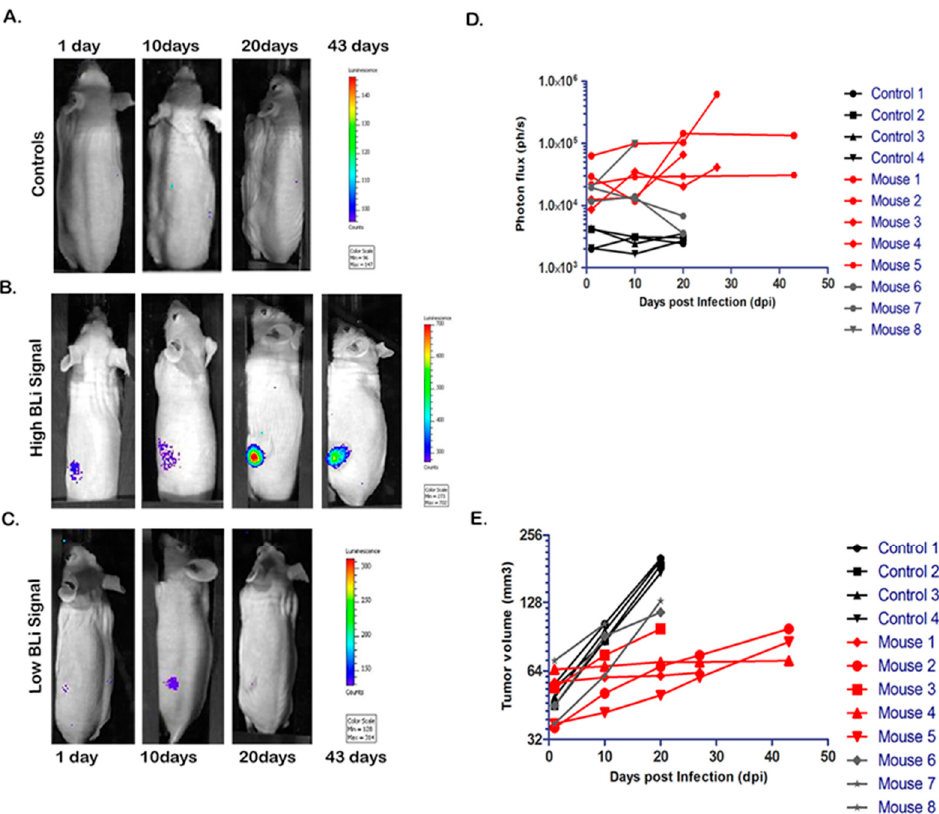
Figure 2. Longitudinal bioluminescence (BLI) imaging of HiBiT-reporter virus infection dynamics in vivo in PC3-LgBiT xenografts . ( A – C ) Infection dynamics in nude BALB/C mice infected with 3.0 × 10 7 PFU of HiBiT-reporter virus. Representative infected mice were imaged at indicated time points by injecting 4.2 µmol of HFz intraperitoneally (i.p.) and monitoring the BLI signal over 43 days for